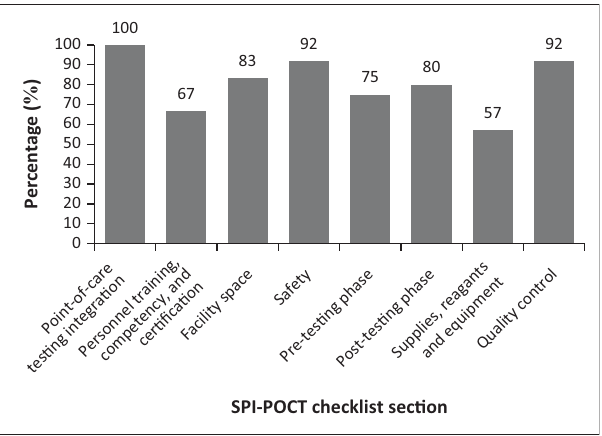
SPI-POCT, Stepwise Process for Improving the Quality of HIV-Related Point-of-Care Testing. FIGURE 1: Median performance scores per Stepwise Process for Improving the Quality of HIV-Related Point-of-Care Testing checklist domain of potential point- of-care early infant diagnosis health facilities ( N = 15) in Lesotho, February